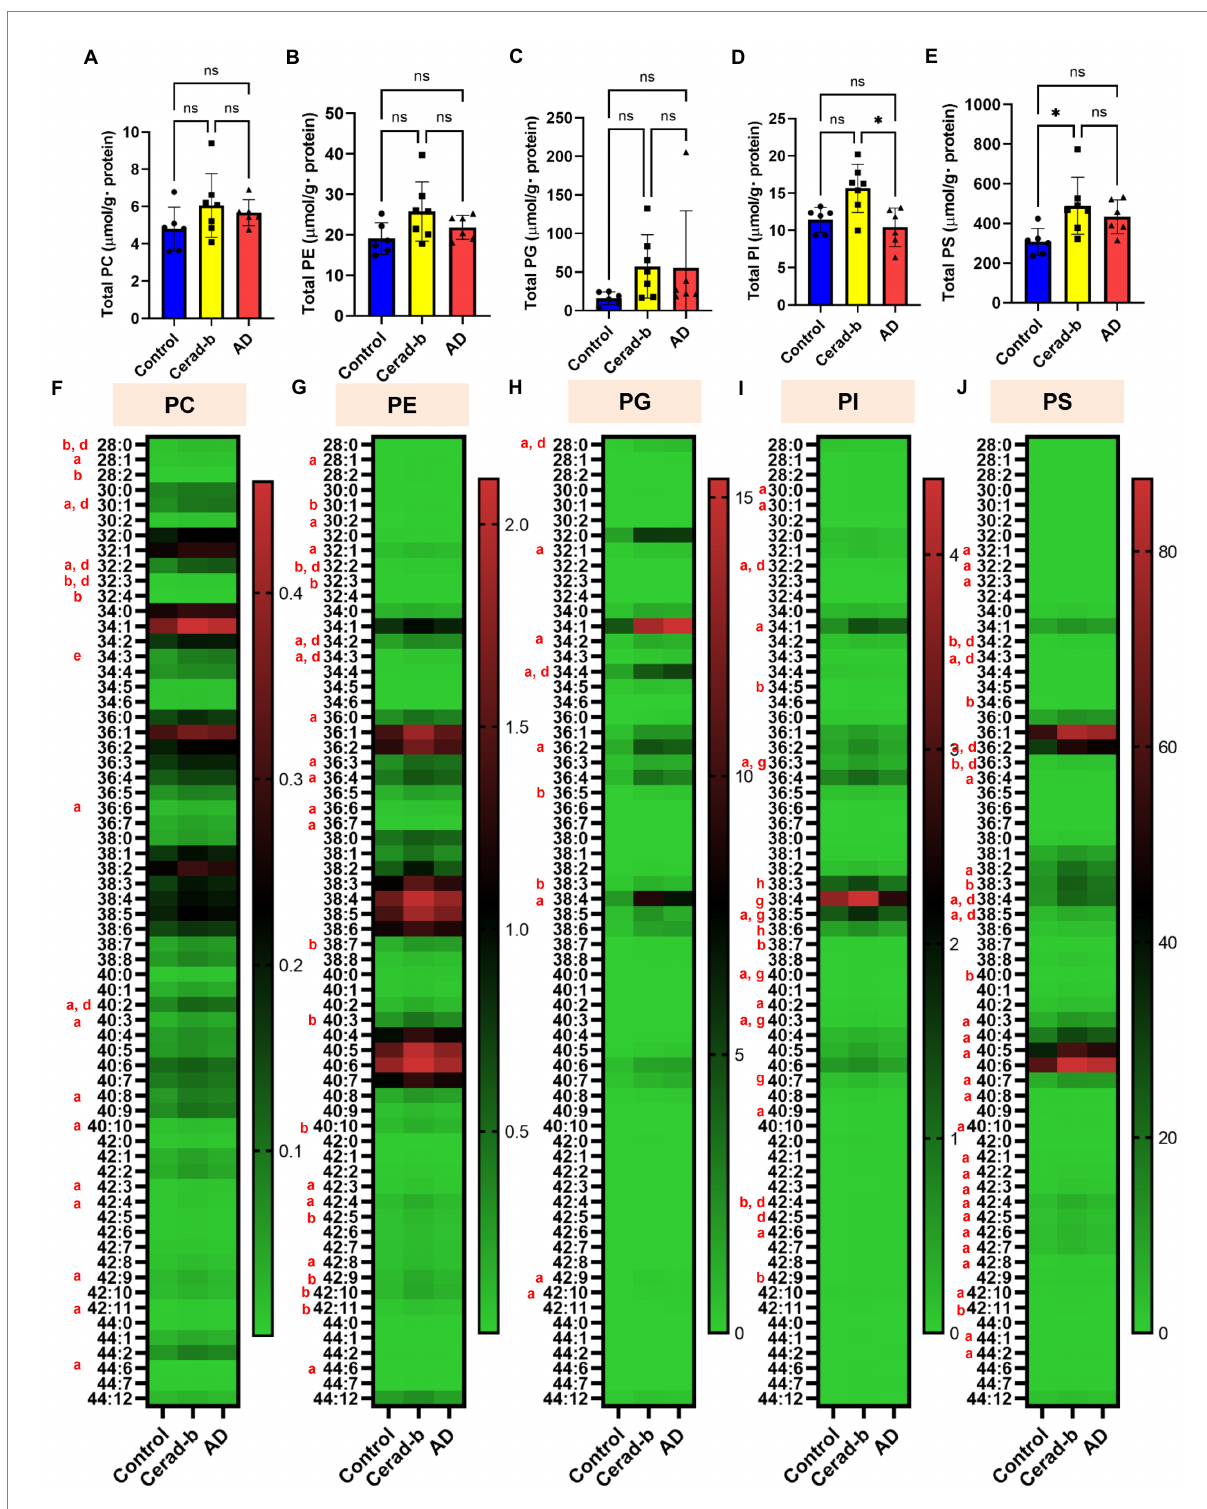
FIGURE 3 Modulations of the diacylphospholipid levels in the brains in AD and Cerad-b. The diacylphospholipid levels were measured in the brains of control subjects ( n = 6), patients with Cerad-b ( n = 7), and patients with AD ( n = 6). The Kruskal-Wallis test, followed by the Steel-Dwass test as a post hoc test, was used to evaluate the difference. (A) Total PC levels. (B) Total PE levels. (C) Total PG levels. (D) Total PI levels. (E) Total PS levels. * p < 0.05. (F) PC species. (G) PE species. (H) PG species. (I) PI species. (J) PS species. ns, not significant; a, p < 0.05 Cerad-b vs. control; b, p < 0.01 Cerad-b vs. control; c, p < 0.001 Cerad-b vs. control; d, p < 0.05 AD vs. control; e, p < 0.01 vs. AD vs. control f, p < 0.001 AD vs. control; g, p < 0.05 Cerad-b vs. AD; h, p < 0.01 Cerad-b vs. AD; i, p < 0.001 Cerad-b vs.